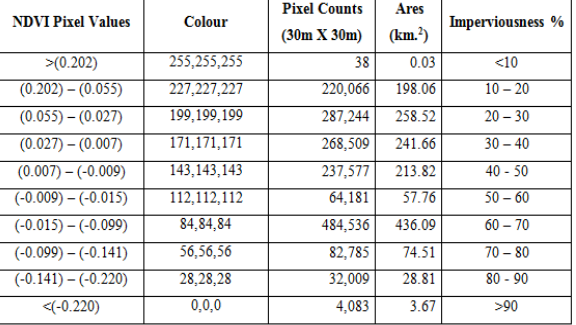
Figure 11 . Impervious Surface Map of